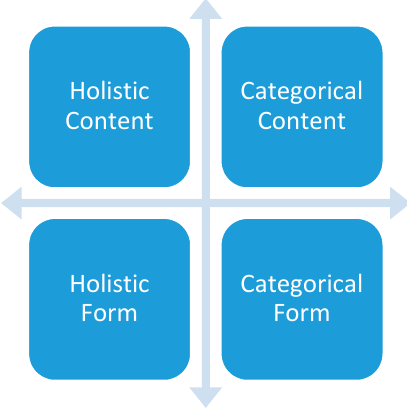
Figure 1. Dimensions of analyzing narratives [48].